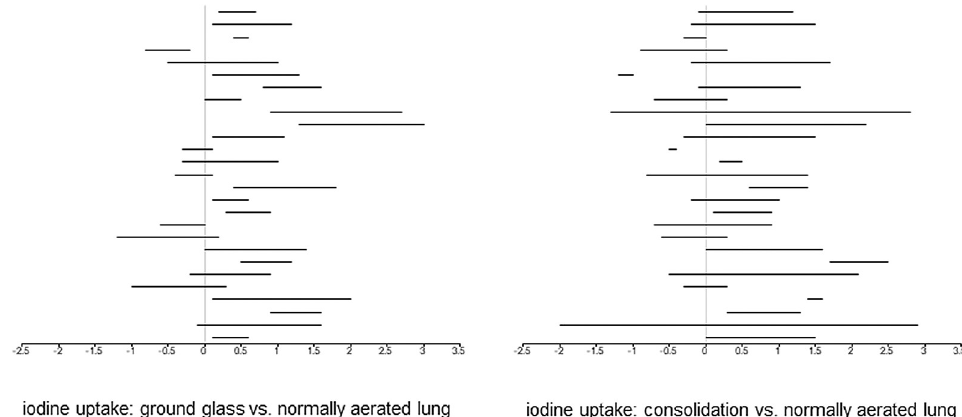
Fig 1. a. Difference of maximum and minimum of iodine uptake (mg/mL; x-axis) in ground-glass opacification compared to normally aerated lung. Each horizontal line represents one patient (y-axis; order of patients from top to bottom as in Table 2). b. Difference of maximum and minimum of iodine uptake (mg/mL; x-axis) in consolidation compared to normally aerated lung. Each horizontal line represents one patient (y-axis; order of patients from top to bottom as in Table 2).